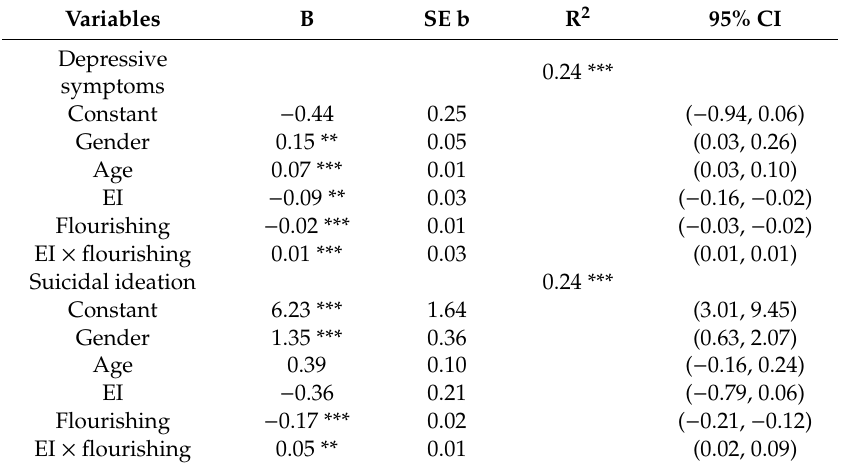
Table 2. Tested models with depressive symptoms and suicidal ideation as